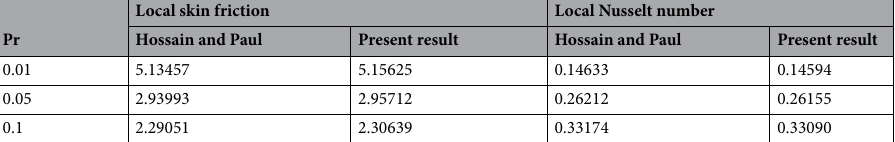
Table 3. Local skin friction and Nusselt number at X = 1.0, steady state are compared with those of Hossain and Paul 44 for different values of Pr, n = 0.5 and M = 0.